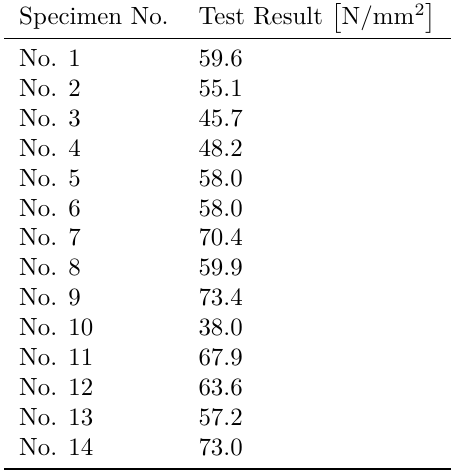
Table 1. Data from compressive strength